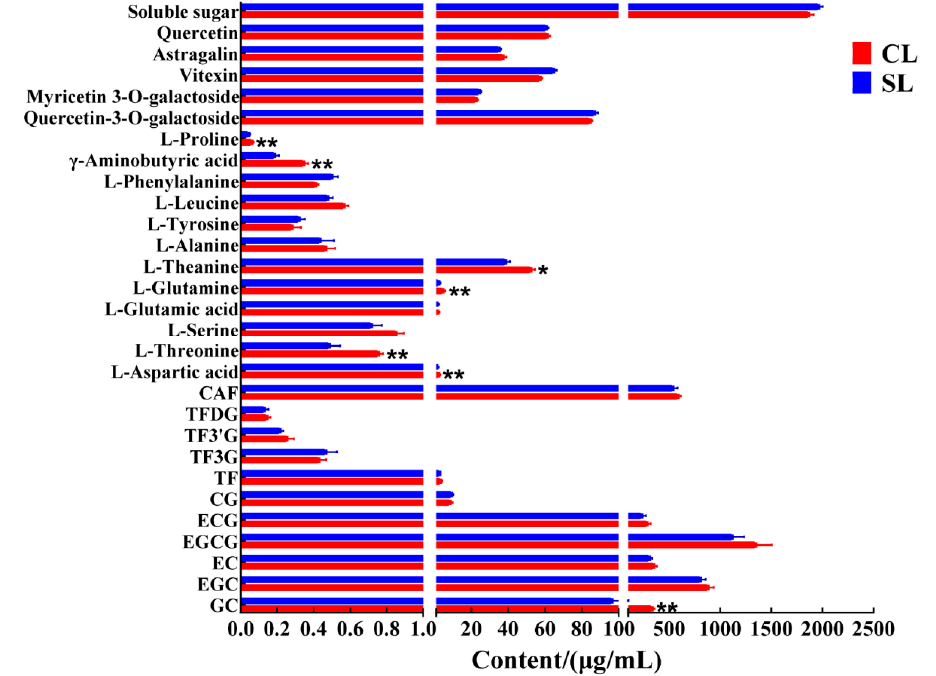
Figure 2. Contents of taste-related components in oolong tea infusion (CL, combined leaf; CS, combined stem; **, p < 0.01; *, p <